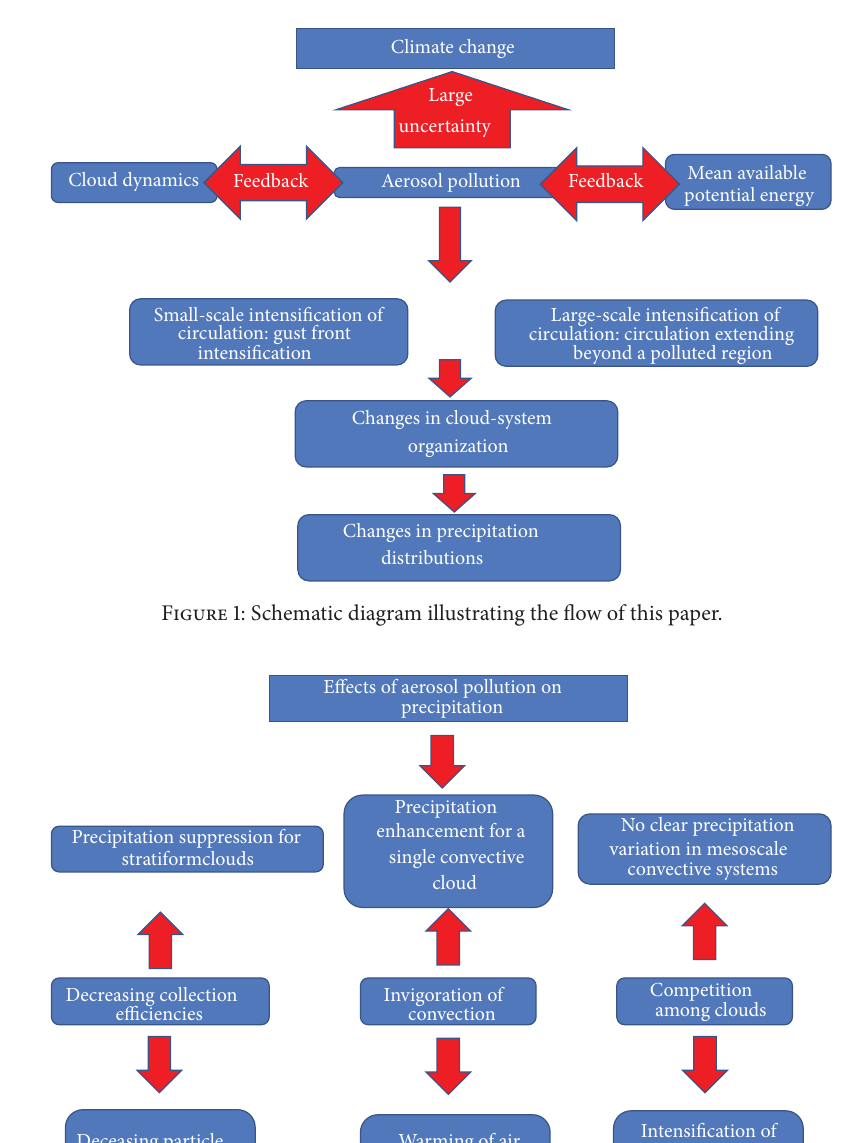
Overall flow of this paper is depicted diagrammatically